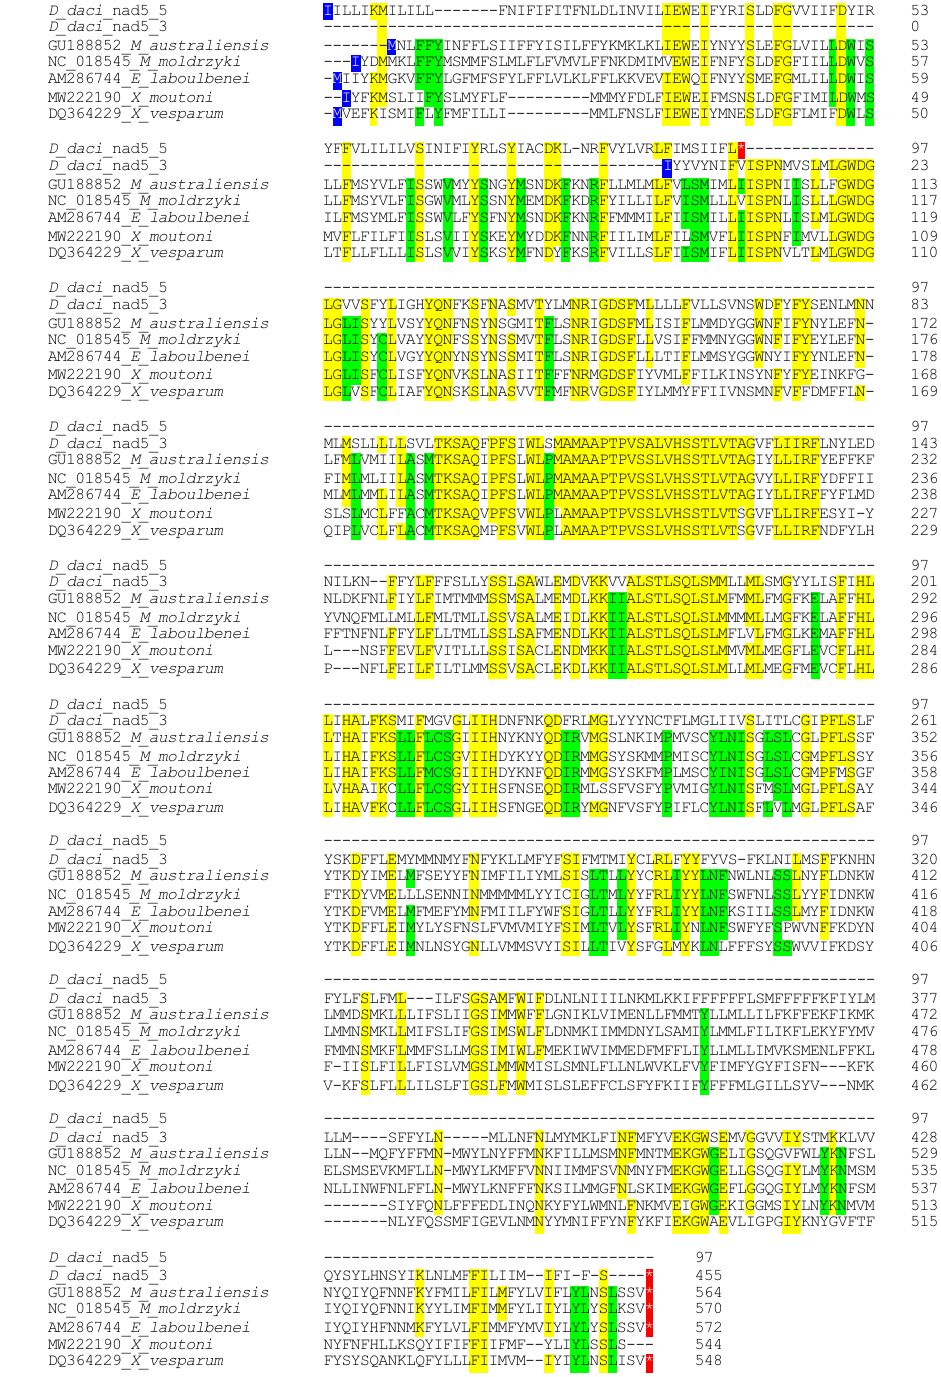
Figure 3. Amino acid (aa) alignment of the nad5 gene of Dipterophagus daci (Bfra485) and five strepsipteran species, Mengenilla australiensis , Mengenilla moldryzki , Eoxenos laboulbenei (Mengenillidae), Xenos vesparum and Xenos cf. moutoni (Xenidae), listed with their GenBank accession numbers . The red-highlighted star indicates stop codons, including a stop codon at position 98 in D. daci , with a new start codon (highlighted in blue) upstream of the mutation. Positions with > 0.5 conserved aa across sequences are highlighted in yellow when D. daci displays the conserved aa, or green when D. daci is different; the 5’ sequence of D. daci reads from an alternative open reading frame starting position than the 3’ sequence due to the deletion that inserts a stop